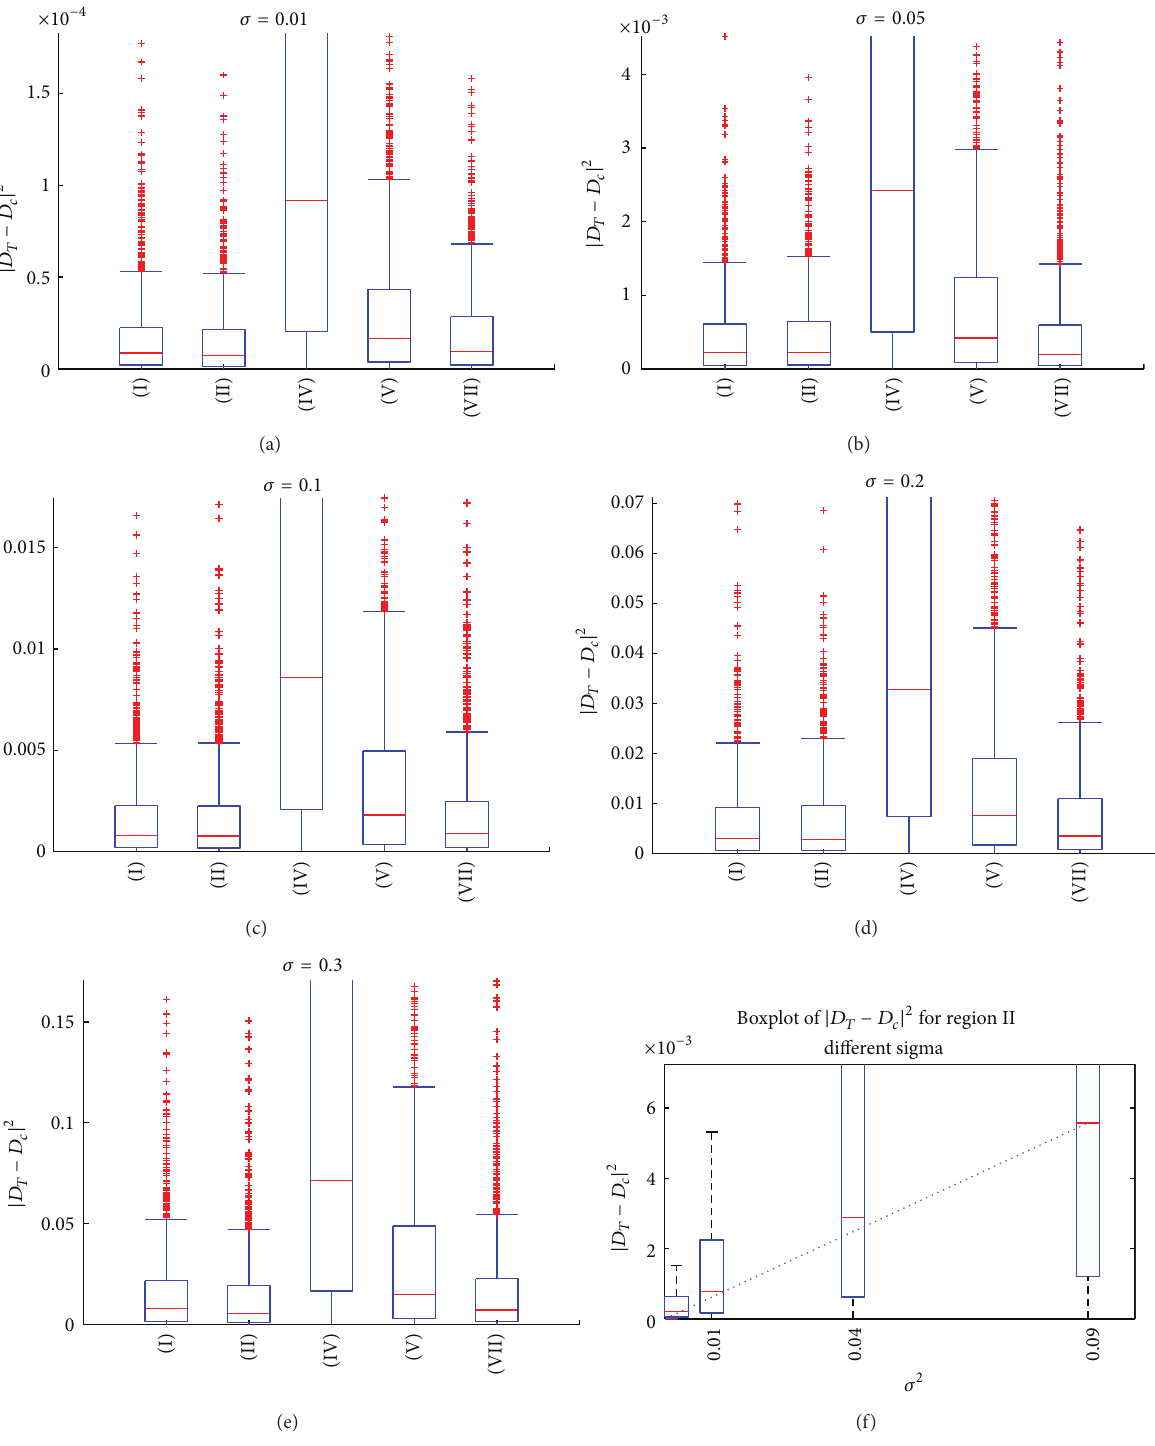
Figure 4: Dependence of |𝐷 𝑇 −𝐷 𝑐 | 2 on the data noise level. Boxplot of error |𝐷 𝑇 −𝐷 𝑐 | 2 for regions (I), (II), (IV) (V), and (VII) for 5 different 𝜎 . (f) shows the confidence intervals for region (II) plotted against the noise variance 𝜎 2 . Note: be aware of different scaling along the vertical axes of each of 6